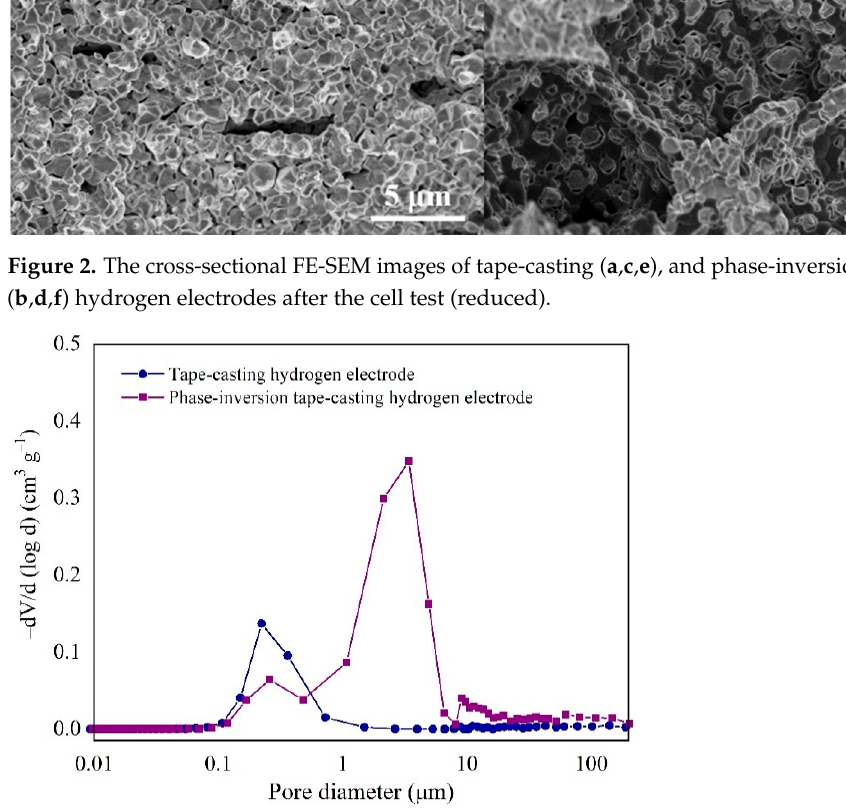
Figure 3. Pore size distribution of tape-casting and phase-inversion tape-casting hydrogen electrodes calcined at 1350 °C after reduction under hydrogen atmosphere at 750 °C for 5 h.